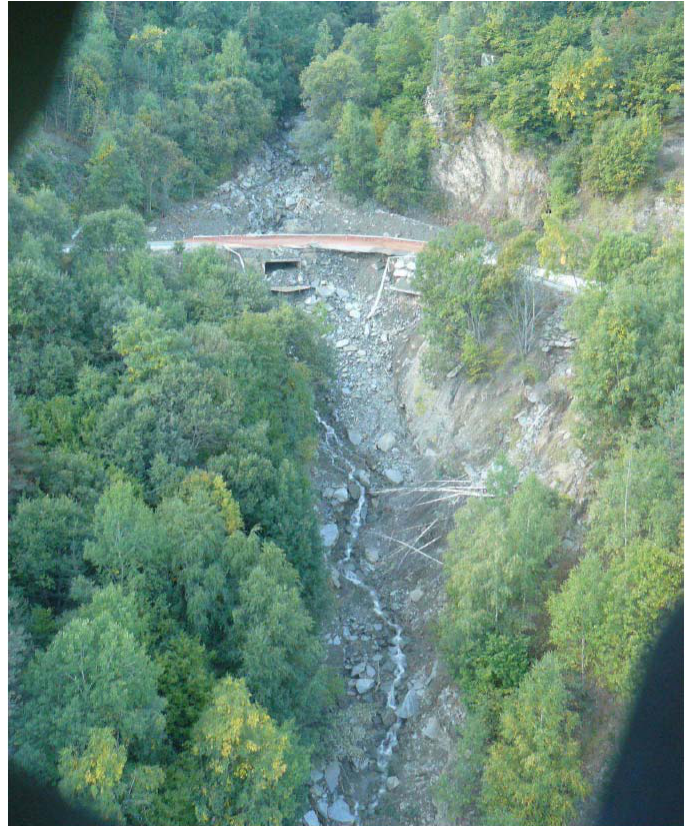
Figure 2. Helicopter view of the erosive breach created by the trigger event of 11–12 November 2008. Image property of ICGC (Institut Cartogràfic i Geològic de Catalunya). Table 2. Historical record for the occurrence of recent torrential flows in the Portain é catchment and their e ff ects on road intersections, indicated by their altitude (TO: total obstruction of the culvert; PO: partial obstruction of the culvert; C: talus collapse; w: water circulation) and by the downstream debris cone (E: erosion; D: